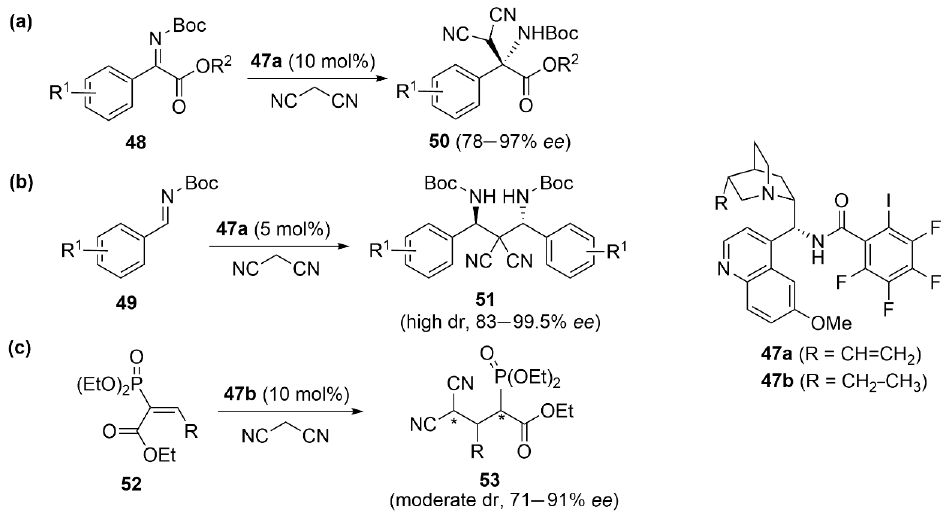
Figure 22. XB/HB-catalyzed asymmetric reactions with Cinchona alkaloid-derived chiral catalysts 47 involving iminoesters ( a ), imines ( b ) and vinyl phosphonates ( c ).